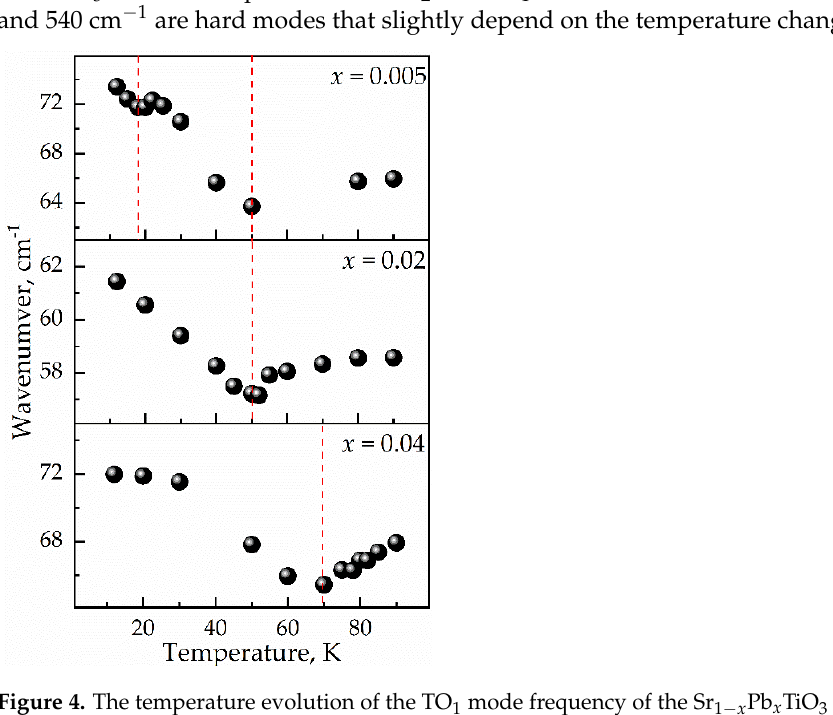
Figure 4. The temperature evolution of the TO 1 mode frequency of the Sr 1 − x Pb x TiO 3 solid solutions at selected concentrations x = 0.005, 0.02, 0.04. The dashed lines indicate the changes in slope for the temperature dependencies of the soft mode frequency.